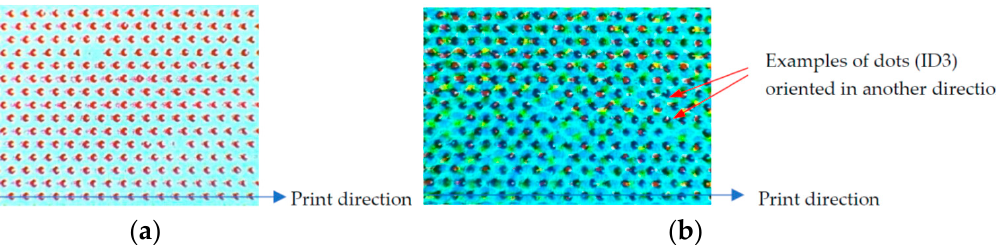
Figure 14. ( a ) Magenta dots with 95% of doughnuts oriented in the print direction; ( b ) Magenta dots with 85% of doughnuts oriented in the print direction. Orientation of the doughnuts vs. print direc- tion. Table 2. ( a ) Statistical values computed for print cyan dots. The most significant values are highlighted in bold. ( b ) Statis- tical values computed for reprint cyan dots. The most significant values are in bold. Features Nb of Dots N° Print Image